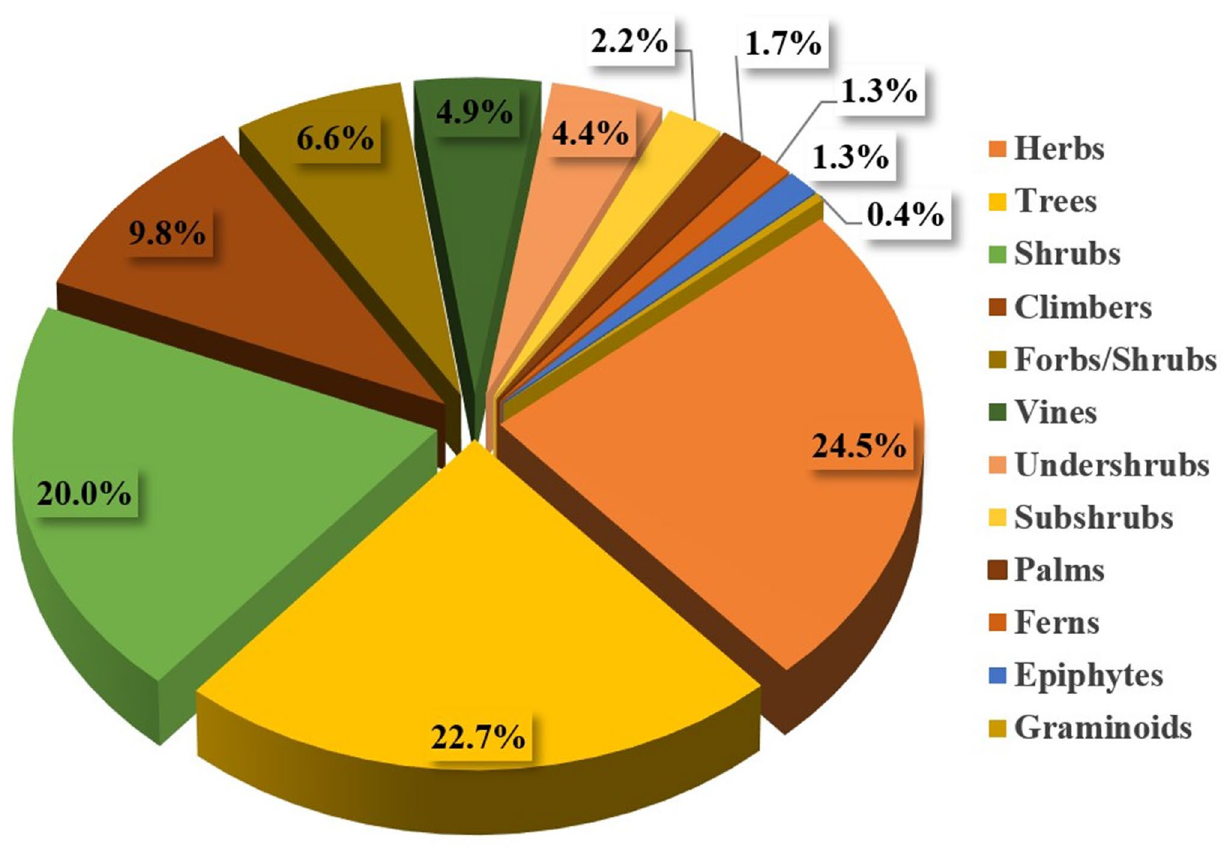
Fig. 1 Growth habits of the covered species